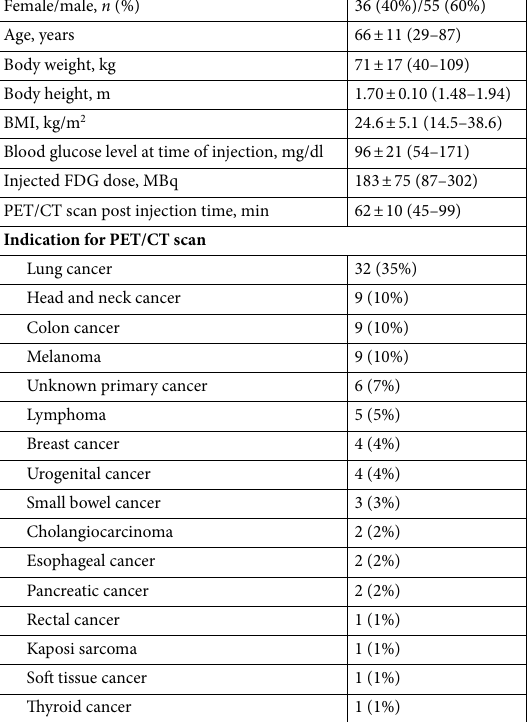
Table 1. Demographic data of study subjects ( n = 91). Values are given as absolute numbers and percentages in parenthesis or mean ± standard deviation (range).